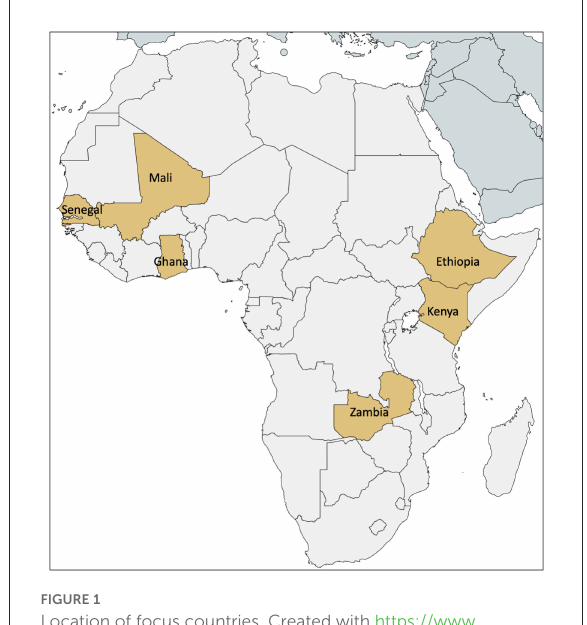
FIGURE1 Location of focus countries. Created with https://www.